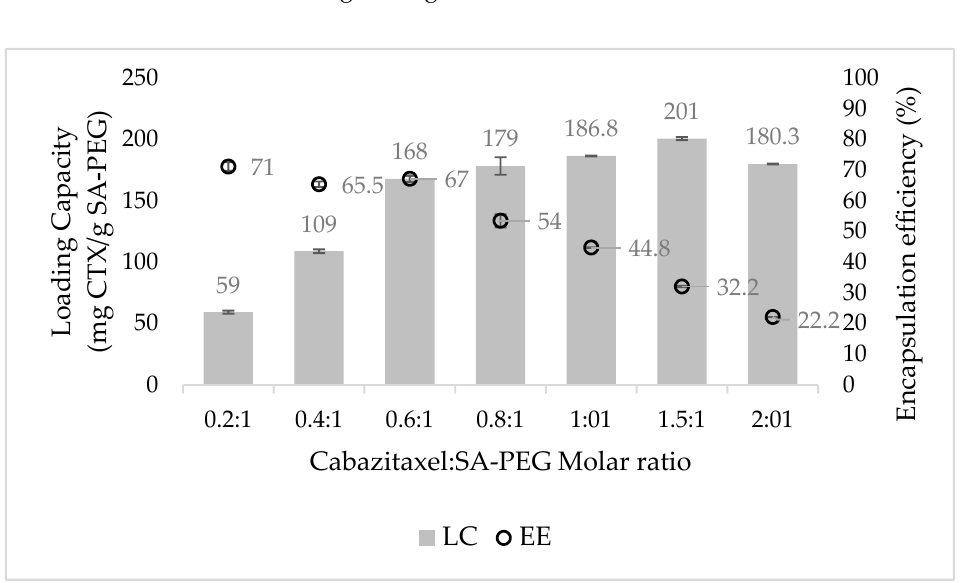
Figure 5. CTX loading capacity (LC) and encapsulation efficiency (EE) at increasing CTX: SA-PEG molar ratios. Columns represent the LC, whereas circles denote EE. Values shown are means ± SE, n = 2 (two independent experiments, each performed in triplicates).